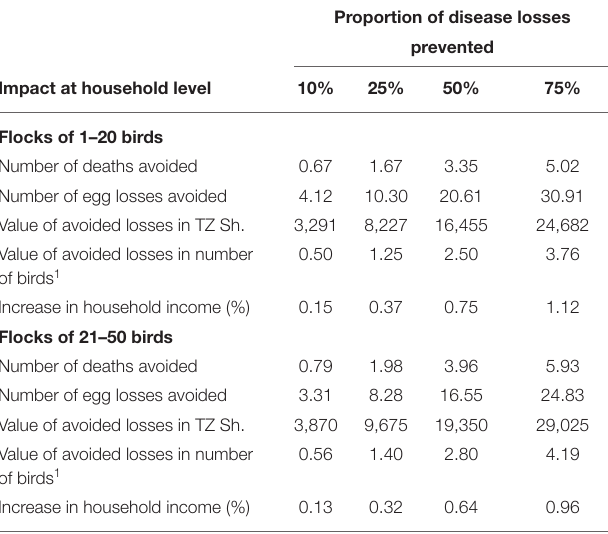
TABLE 7 | Household-level impacts of biosecurity interventions reducing the proportion of birds lost to disease by 10, 25, 50, and 75% in flocks of 1–20 and 21–50